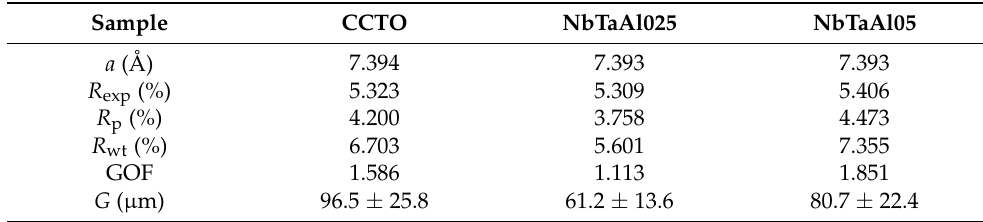
Table 1. Structural data obtained from the Rietveld refinement and mean grain size ( G ) for CCTO, NbTaAl025, and NbTaAl05